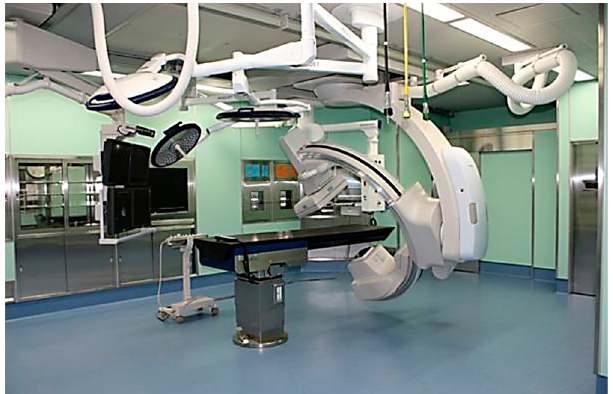
Figure 1. Photograph of the hybrid operating room system (HORS).